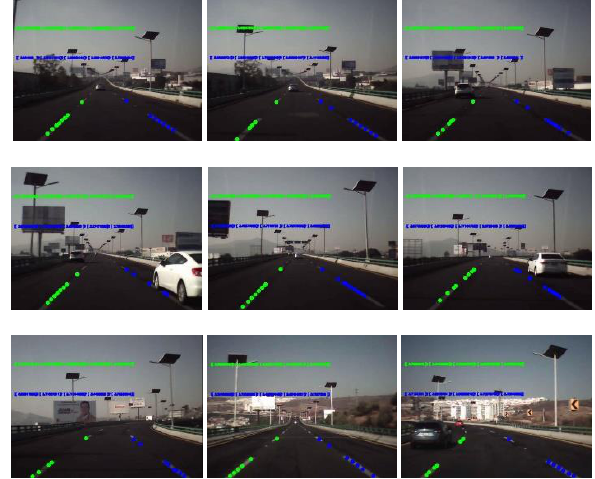
Figure 9. Nine of the images with the ellipses superimposed by the algorithm over the